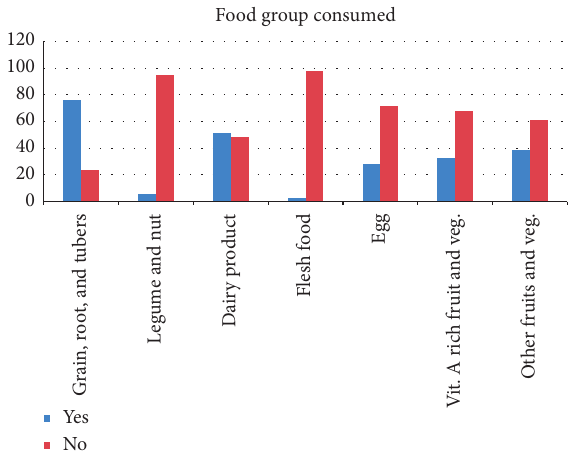
Figure 1: Types of food groups consumed among 6–23 months children. Factors associated with appropriate dietary diversity feeding practice. Table 4: The result of bivariate and multivariable logistic regression to assess the association of adequate dietary diversity feeding practice and sociodemographic, economic, and household factors among 6–23-month children in Birbir Town, Ethiopia, 2018, ( n �